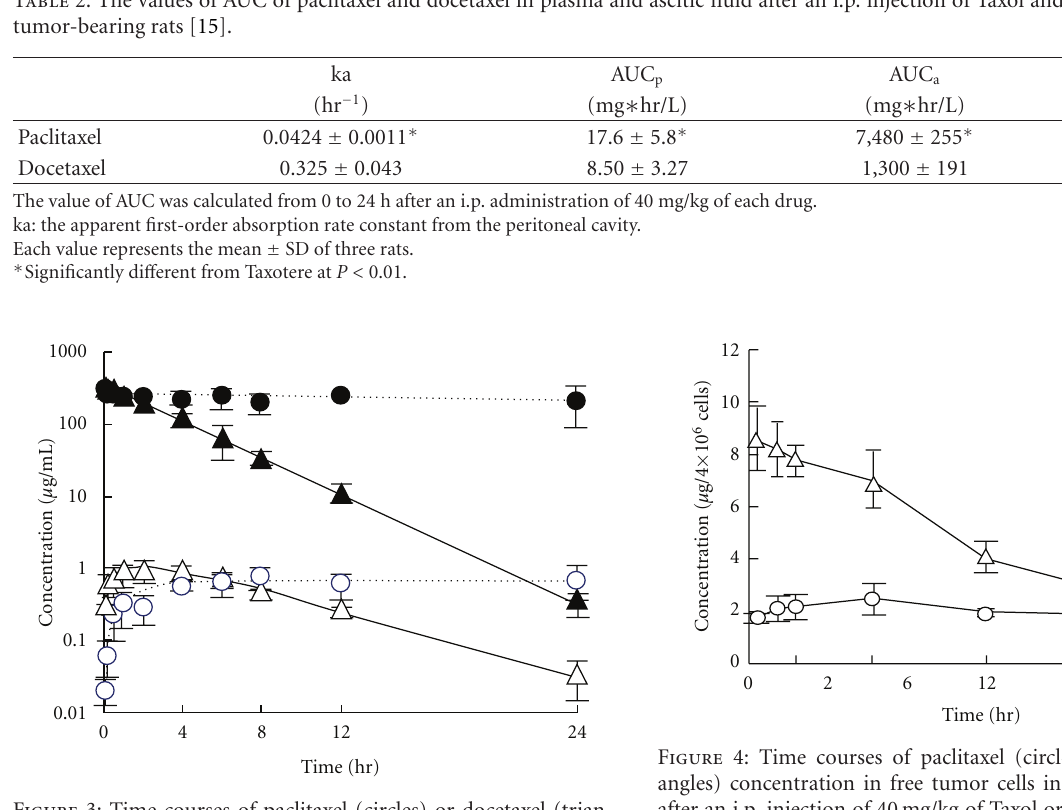
Figure 3: Time courses of paclitaxel (circles) or docetaxel (trian- gles) concentration in ascitic fluid (closed symbols) and plasma (open symbols) after an i.p. injection of 40 mg/kg of Taxol or Taxotere into AH130 tumor-bearing rats [15]. Each point with bar represents the mean ± SD of three rats.